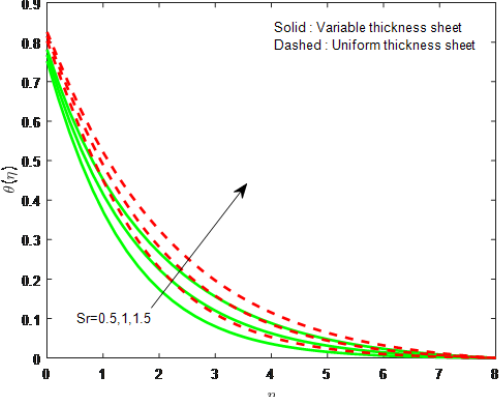
fected by the sundry physical quantities. Results explored for the flow over a uniform and a non-uniform thickness surfaces. The numerical observations are as follows: